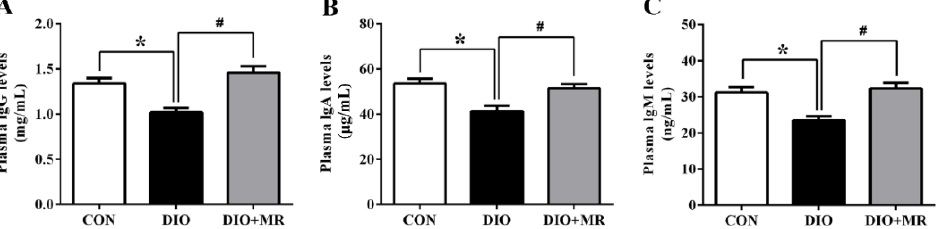
Figure 8. Effects of MR on plasma IgG levels ( A ), plasma IgA levels ( B ), and plasma IgM levels ( C ) in obese mice. IgG, immunoglobulin G; IgA, immunoglobulin A; IgM, immunoglobulin M. All data are shown as mean ± SEM ( n = 10). * p < 0.05 versus CON; # p < 0.05 versus DIO.